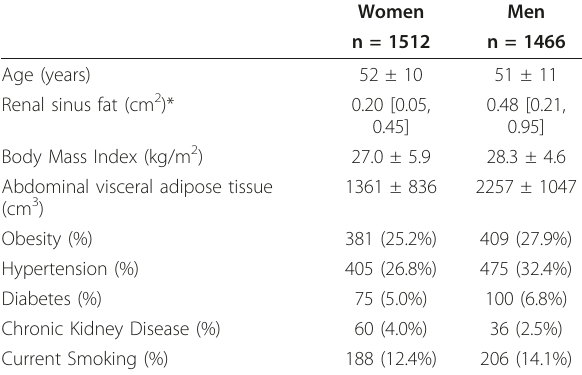
Table 1 Study sample characteristics by sex.